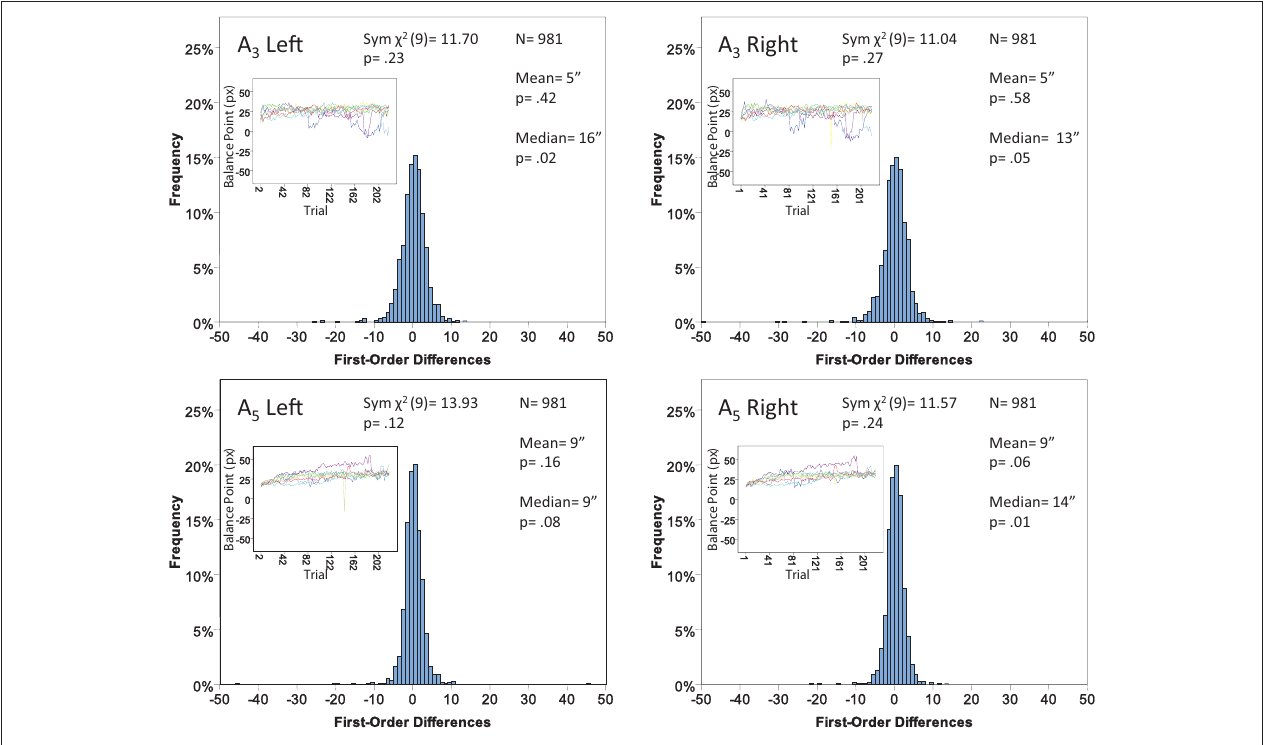
Figure 15 | Histograms of the ∆ ’s for the shape experiment, participant P7. The rest as in Figure